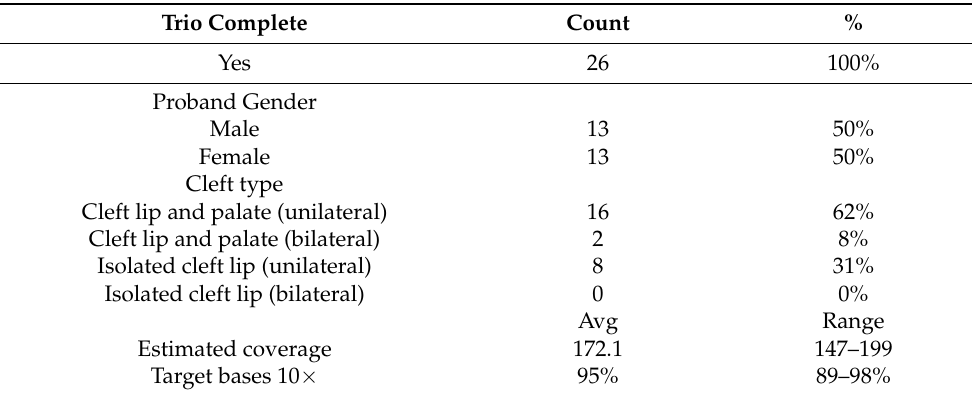
Table 1. General overview of the